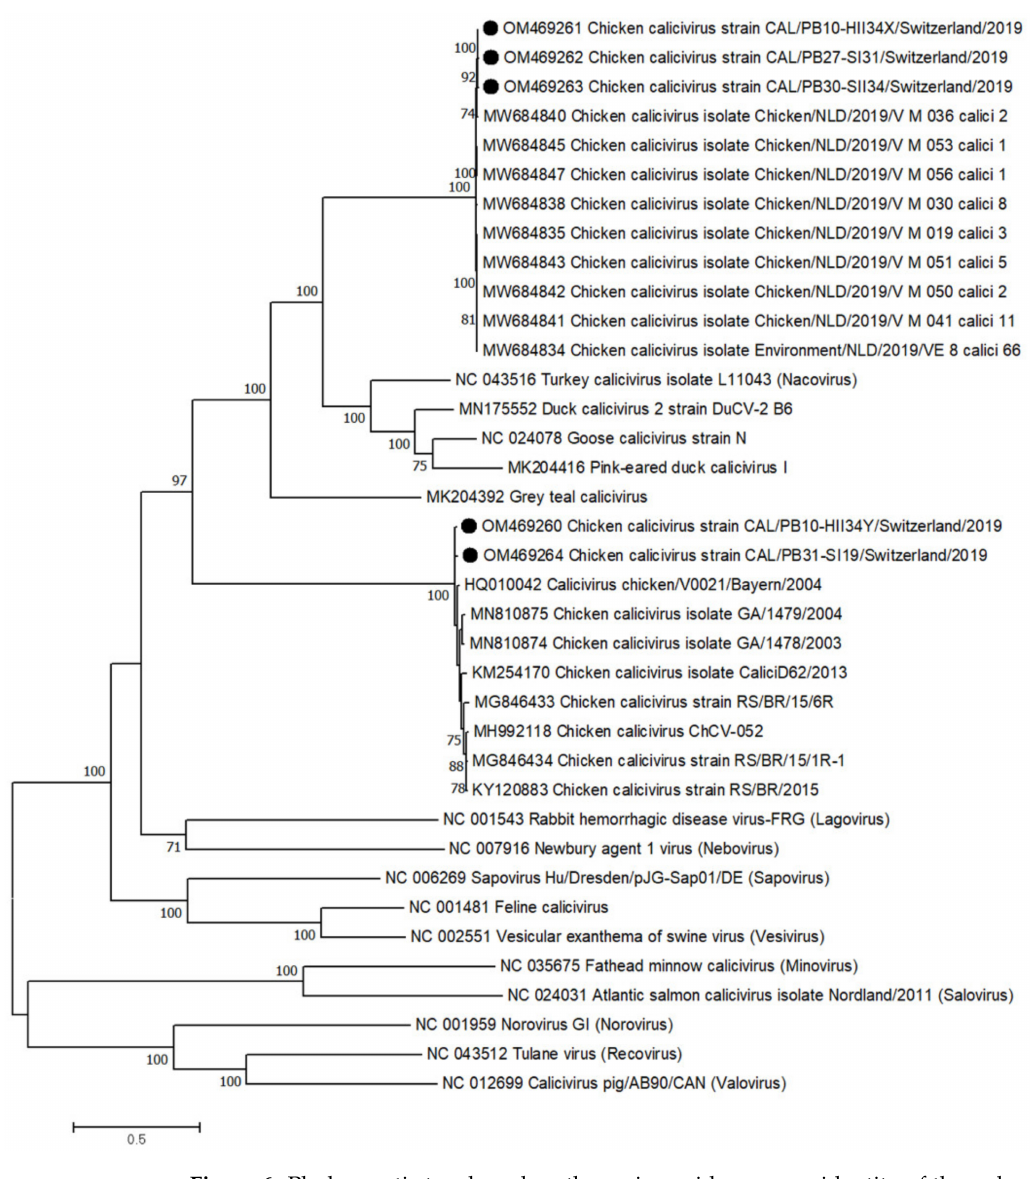
Figure 6. Phylogenetic tree based on the amino acid sequence identity of the polyprotein of refer- ence strains from the genus Calicivirus , most closely related to the contigs from this study (black dots). Phylogenetic analysis was performed using the maximum likelihood algorithm based on the Tamura–Nei model with the 1000 replication bootstrap method. Only values ≥ 70% were displayed. Evolutionary analyses were conducted using MEGA